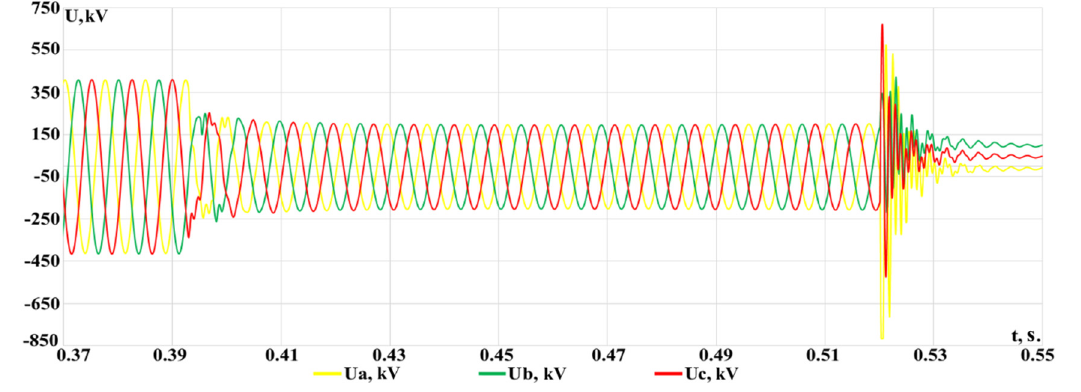
Figure 14. Generator G 2 active power and turbine torque for a case of FV ( A i = 3.5 pu). Figure 15. Generator G 2 active power and turbine torque for a case of FV ( A i = 3 pu). The value of Ai = 3.5 pu. allows for a realization of the process of FV at 10.5% faster than at A i = 3 pu. and only at 2.8% slower than at A i = 4 pu. The increase in the FV speed